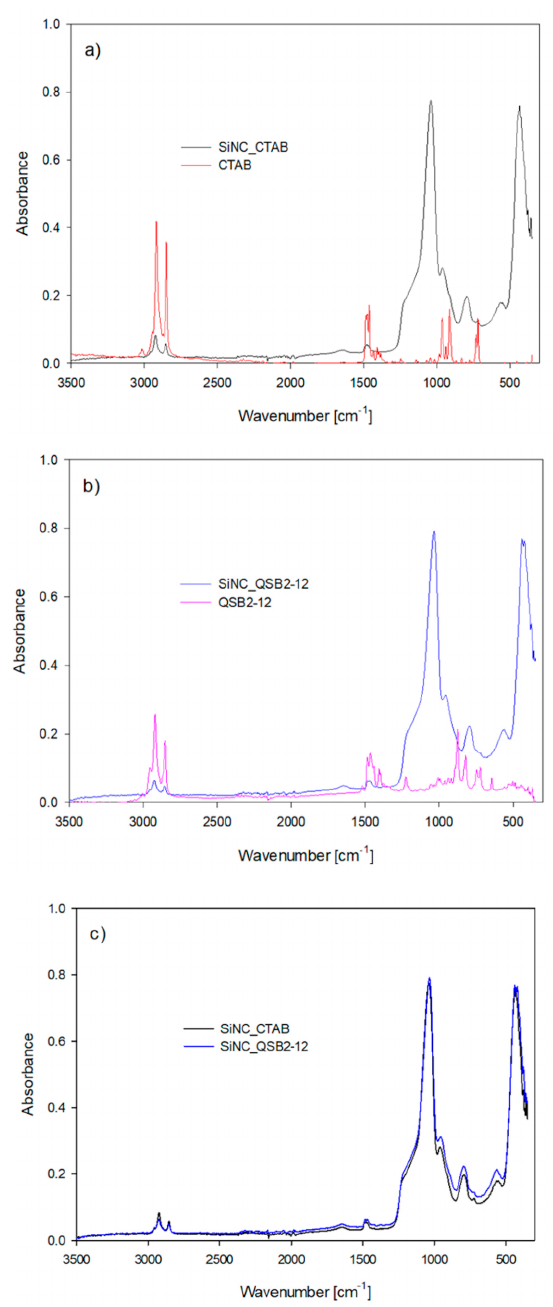
Figure 4. Overlapped Fourier-transformed infrared spectroscopy (FTIR) spectra of ( a ) SiNC_CTAB and CTAB, ( b ) SiNC_QSB2-12 and QSB2-12, and ( c ) SiNC_CTAB nd SiNC_QSB2-12.